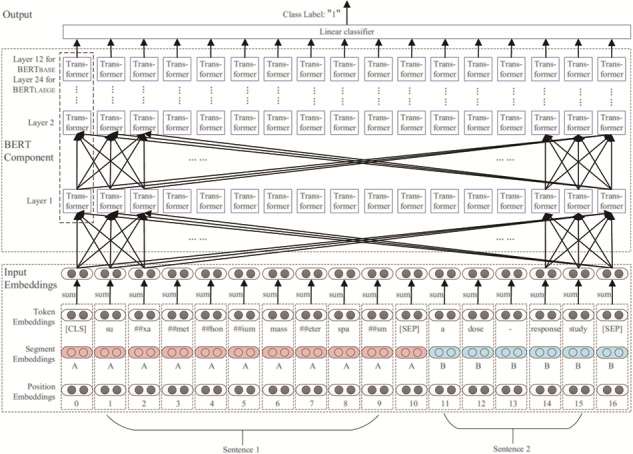
An illustration of the architecture of BERT (18).